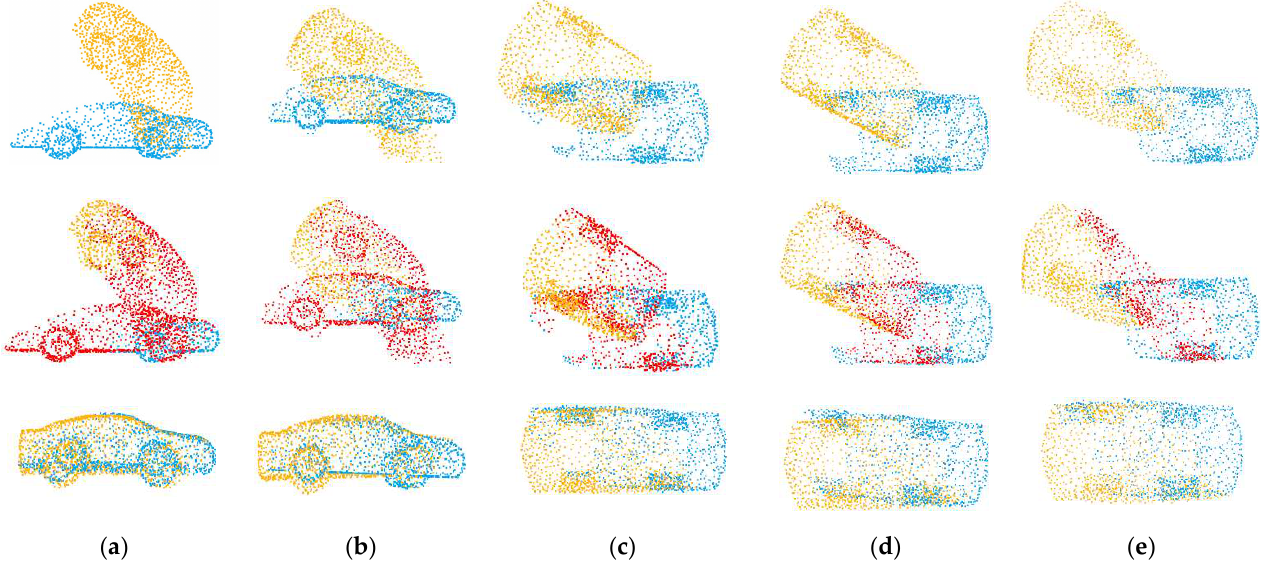
Figure 10. Example results on partially overlapping point clouds with varying overlap rates. The source point cloud is yellow, the target point cloud is blue, and the overlapping regions predicted by the network are red. The top row shows the initial positions of the two point clouds, and the bottom row shows the results of registration. ( a ) OR = 0.69; ( b ) OR = 0.58; ( c ) OR = 0.47; ( d ) OR = 0.40; ( e ) OR = 0.32.